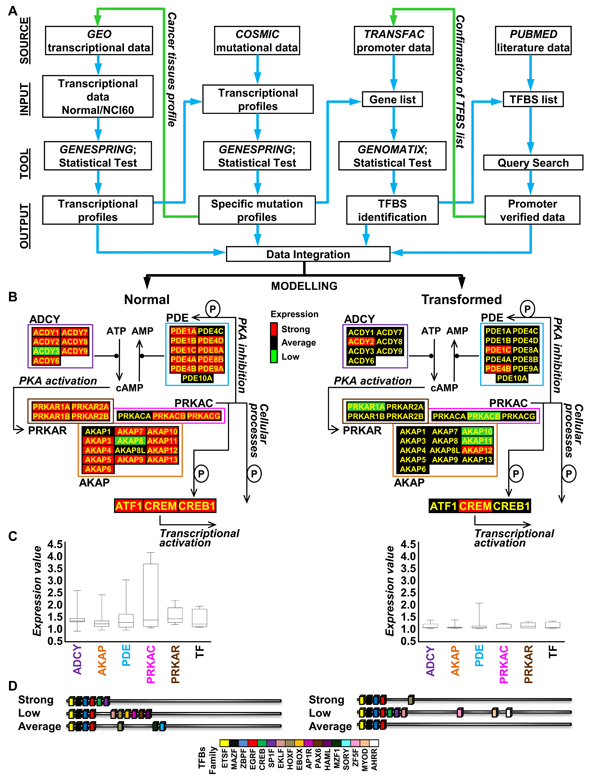
Flowchart of our web-based and statistical strategy used to elucidate the relation between PKA encoding genes transcriptional profiles and oncogenic mutations. (A) Flow chart of our web-based and statistical strategy with indication of some of the databases (Source) used, the type of data analyzed (Input), the specific program and statistical test (Tool) used and the result obtained (Output). (B) Graphical representation of the block diagram summarizing functional interconnections within the PKA pathway module with indication of the expression level (geometric mean) of each gene belonging to the network -Strong (red), Average (black) and Low (green)- as identified by our analysis both in normal (B, left) and transformed samples (B, right). (C) Boxplots of the expression of PKA pathway-encoding genes in normal (C, left) and transformed (C, right) samples, grouped for functional classes (ADCY: adenylyl cyclase; AKAP: A-kinase anchor protein; PDE: phosphodiesterase; PRKACR: PKA regulatory subunit; PRKAC: PKA catalytic subunit). The represented value is the median. (D) Schematic representation of the TFBSs (color-coded) identified in the promoters of PKA pathway-encoding genes of normal and transformed samples. Each cartoon represents the promoter structure resulting from the merge of the TFBS identified in ≥ 70% of the gene promoters of all normal samples and transformed samples.